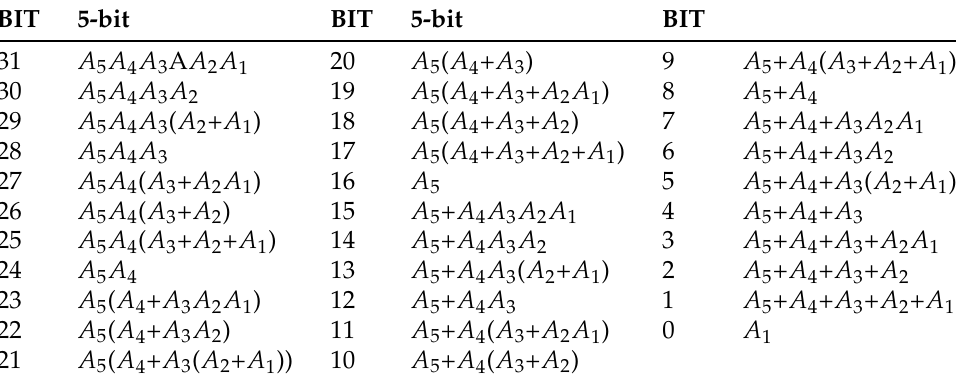
Table 2. Lower five bits coding to thermometer codes.